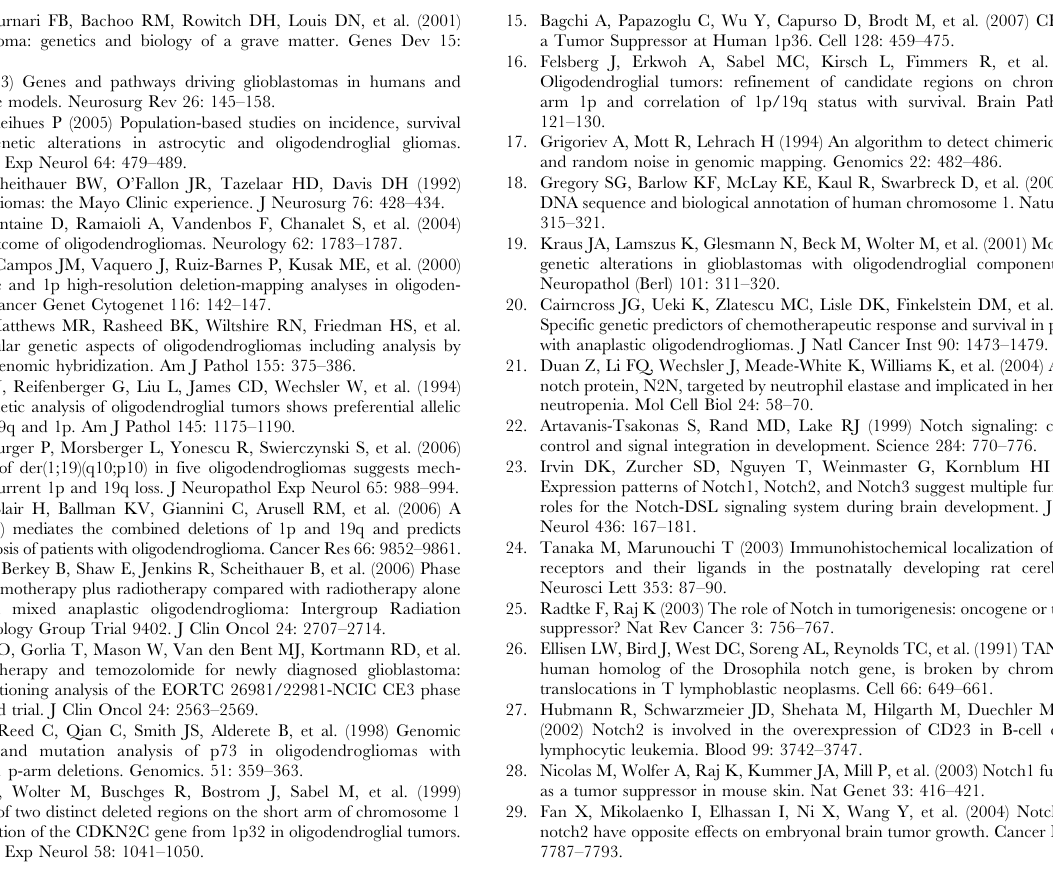
Figure S1 Kaplan Meier cumulative survival curve of OD Haplotype H10 compared to OD Haplotype H1 and GBM Haplotype